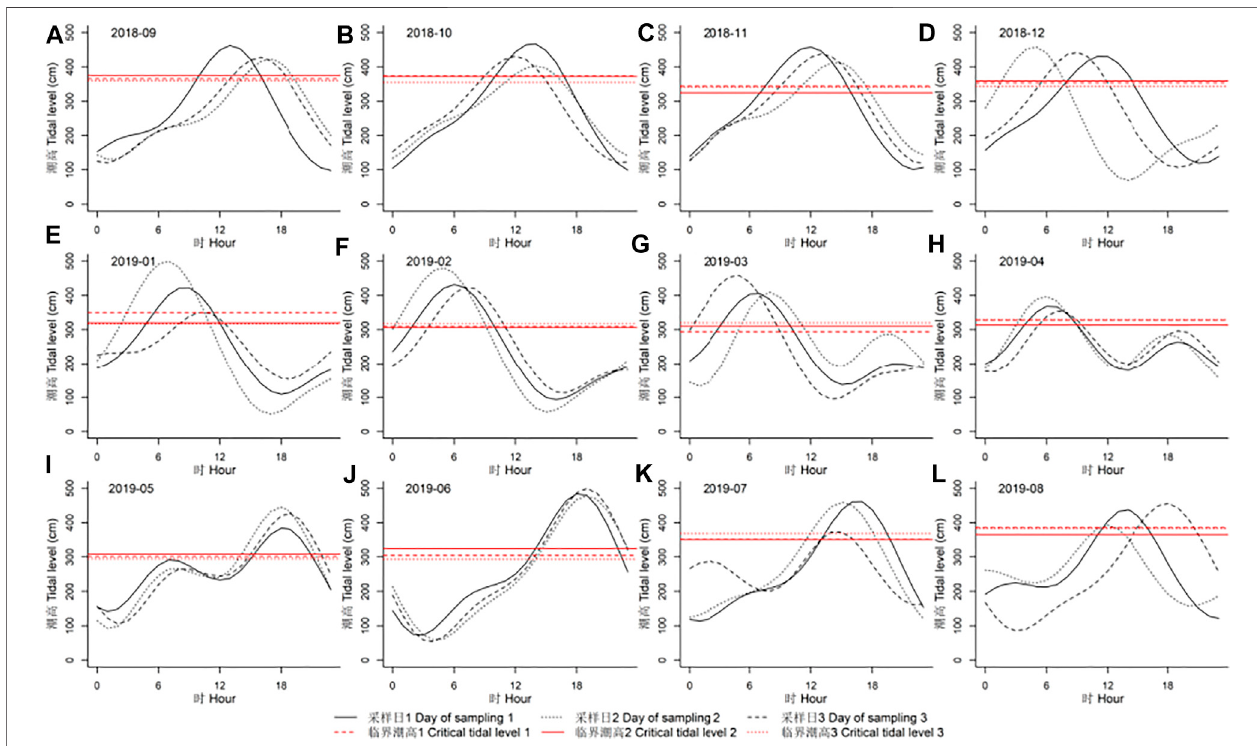
FIGURE 2 | (A) The distribution of tidal levels and critical tidal levels in mangrove vegetation areas from September 2018 to August 2019.